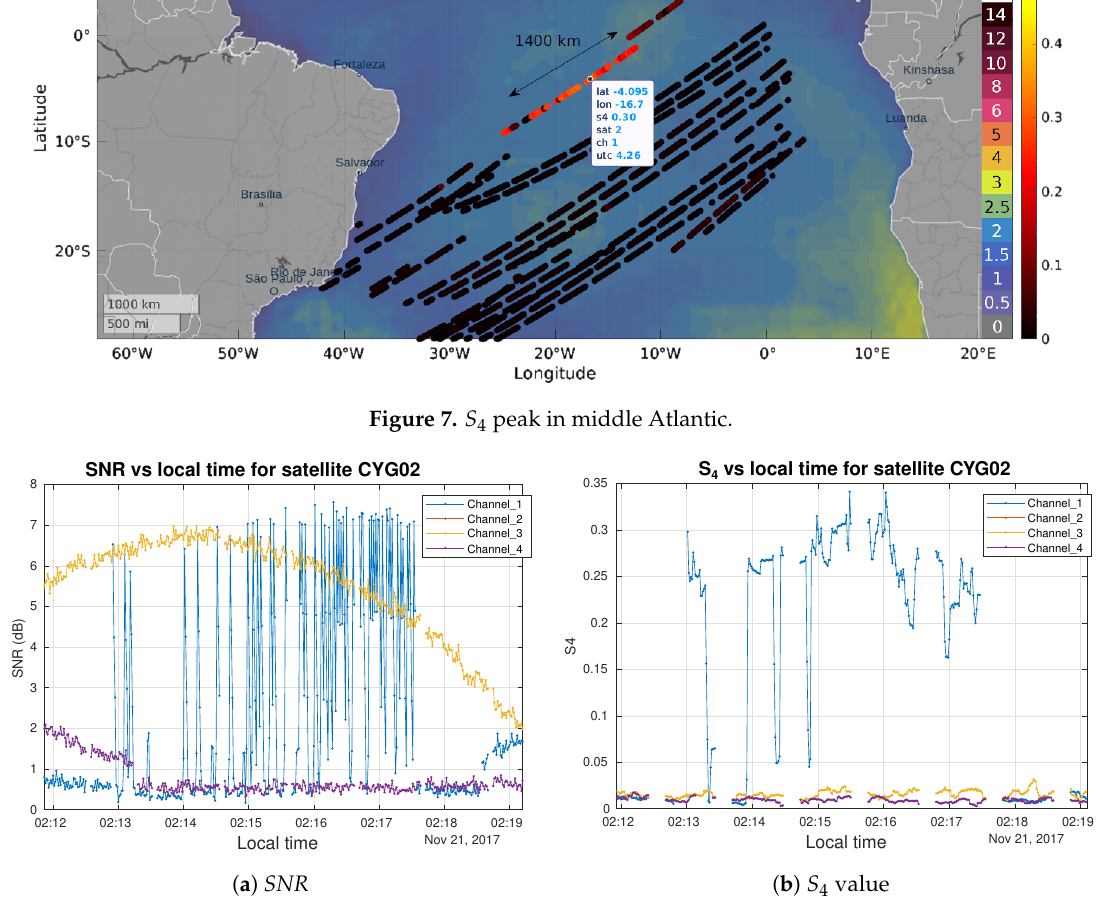
Figure 8. SNR fluctuations and S 4 value for 21 November 2017 peak vs LT (Local Time) corresponding to previous Figure